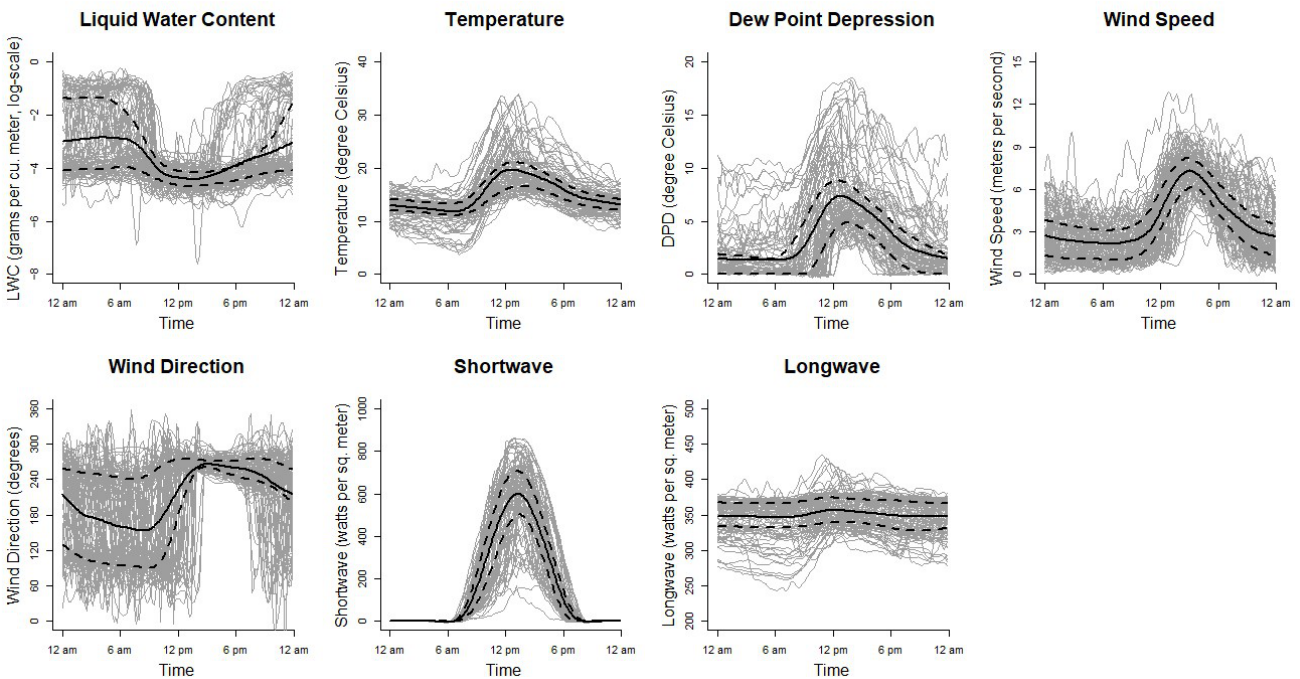
Figure 1. Observed daily trends (gray) and smoothing splines for overall average (black): liquid water content (LWC), temperature (T), dew point depression (DPD), wind speed (WS), wind direction (WD), shortwave (SW), and longwave (LW), observed from July 29 to November 6, 2020. Solid curves are average trends; dotted curves are the first and third quartiles.